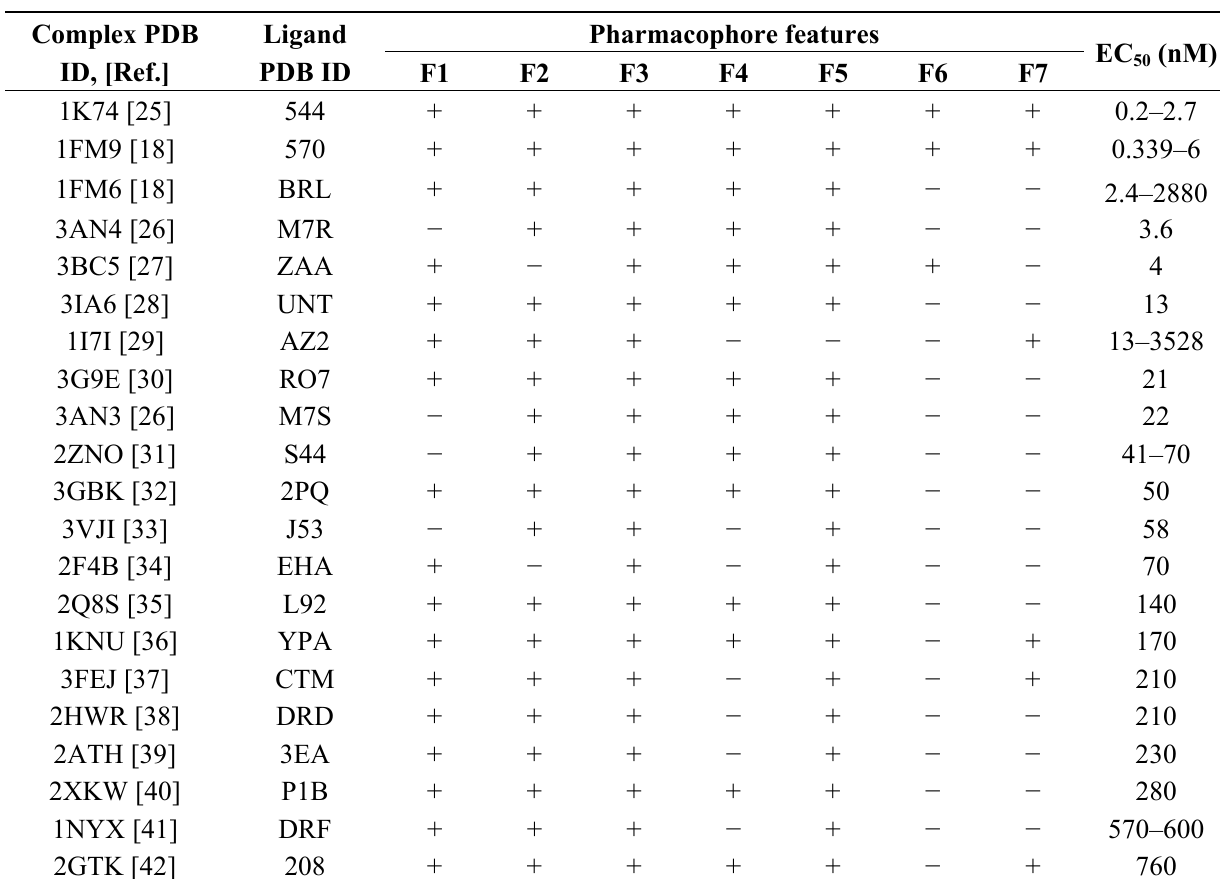
, transactivation activity; 50 values (the lowest value 50